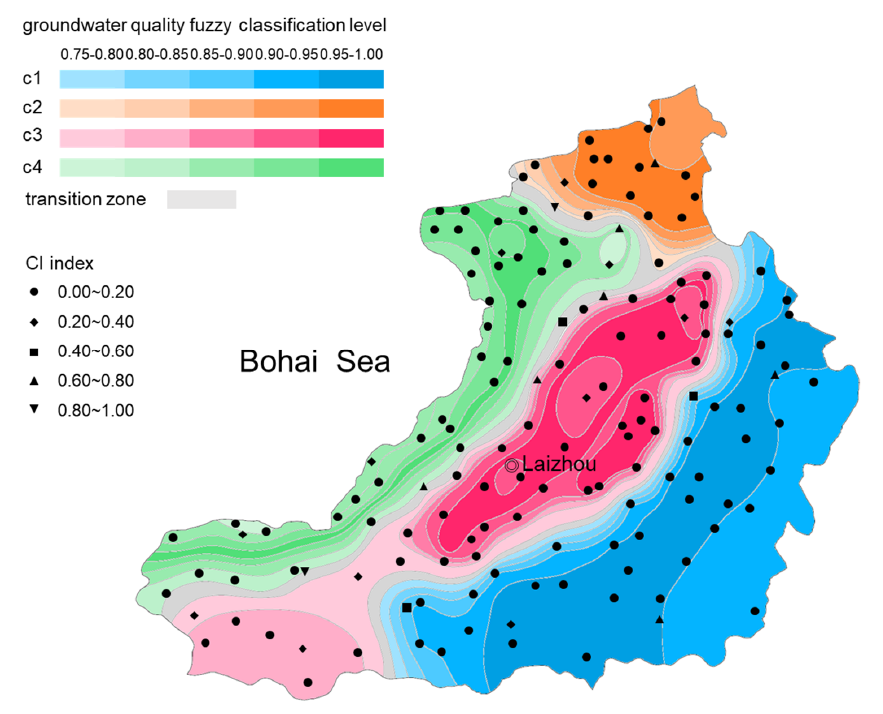
Figure 17. C onfusion index and groundwater quality fuzzy classification results. Figure 17. Confusion index and groundwater quality fuzzy classification